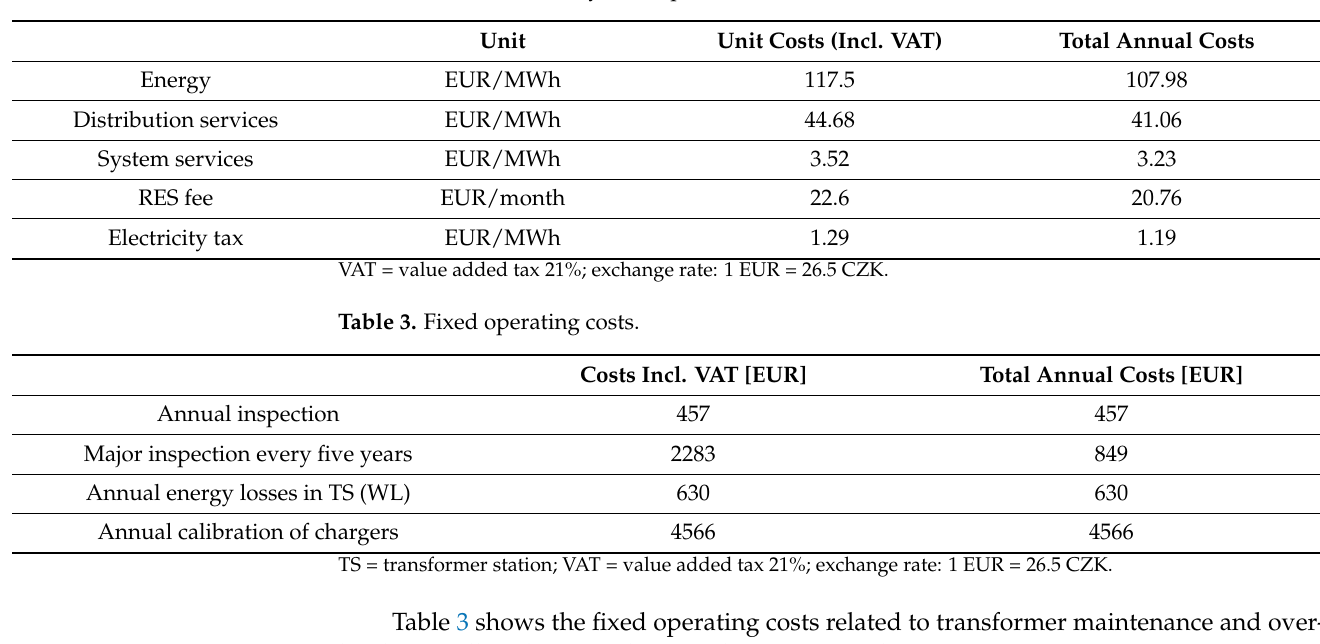
Table 2. Annual electricity bill (reproduced from [68,69]).